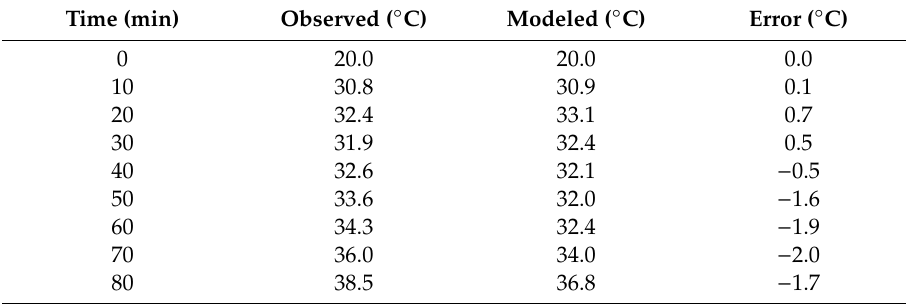
Table 3. Comparison of modeled temperature of the front surface with that of the observed